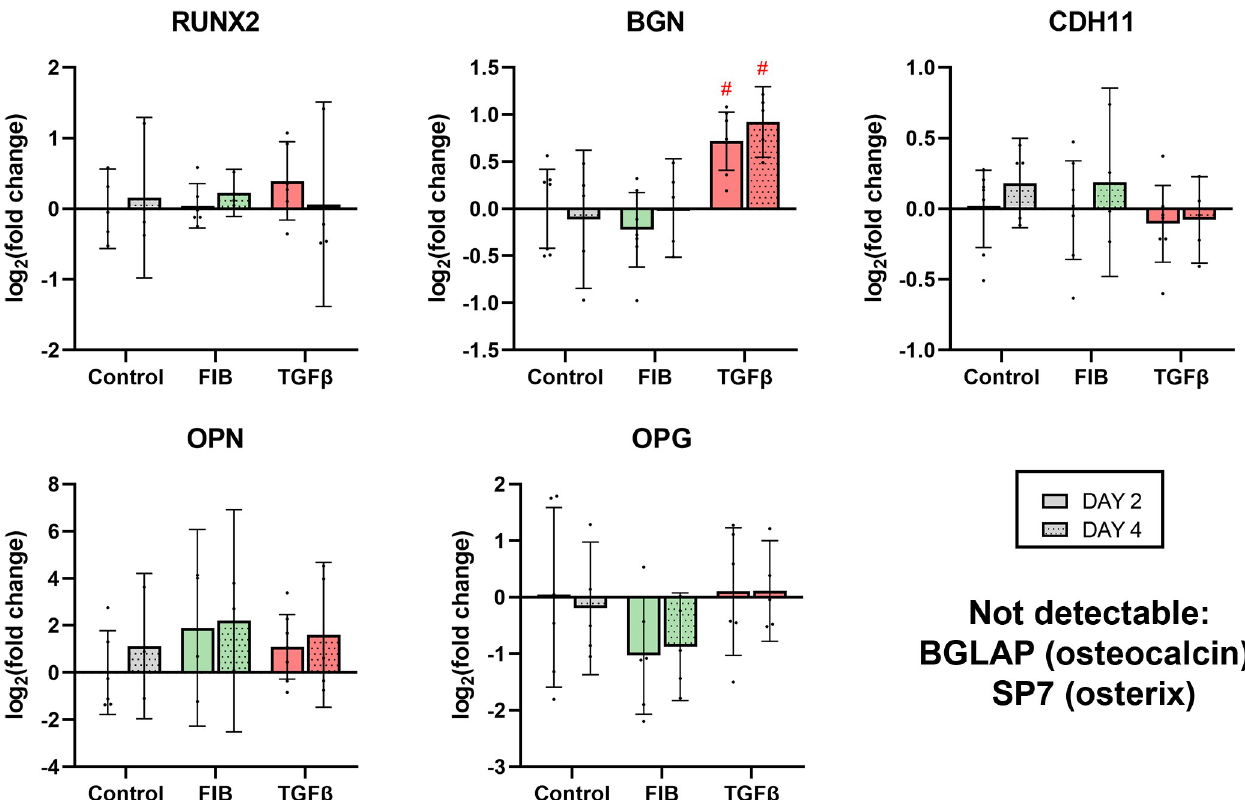
Fig 8. FGF-2 has no effect on expression of osteoblast-associated genes. Results of RT-qPCR on a panel of 7 osteoblast associated genes. Note that expression of BGLAP and SP7 was below the detectable level. � p < 0.05, #p < 0.01, dots represent biological replicates (n = 7 on day 2, n = 5 on day 4), error bars represent 95%